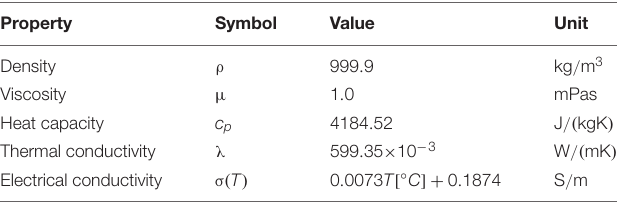
TABLE 1 | Material properties of the Ringer’s solution used as the treatment medium for the trials, as deployed in the CFD simulation. Property Symbol Value Unit Density 999 .